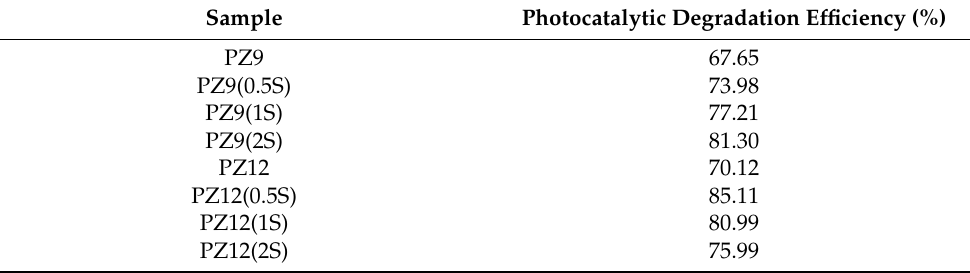
Figure 12. Photocatalytic degradation performance of various PZ12 fibers under visible light irradiation: ( a ) absorbance against time, and ( b ) ln(C/C 0 ) against time (R 2 of approximation: 0.93–0.96). Table 6. Photocatalytic efficiency by various as-prepared filters towards degradation of MB under visible light